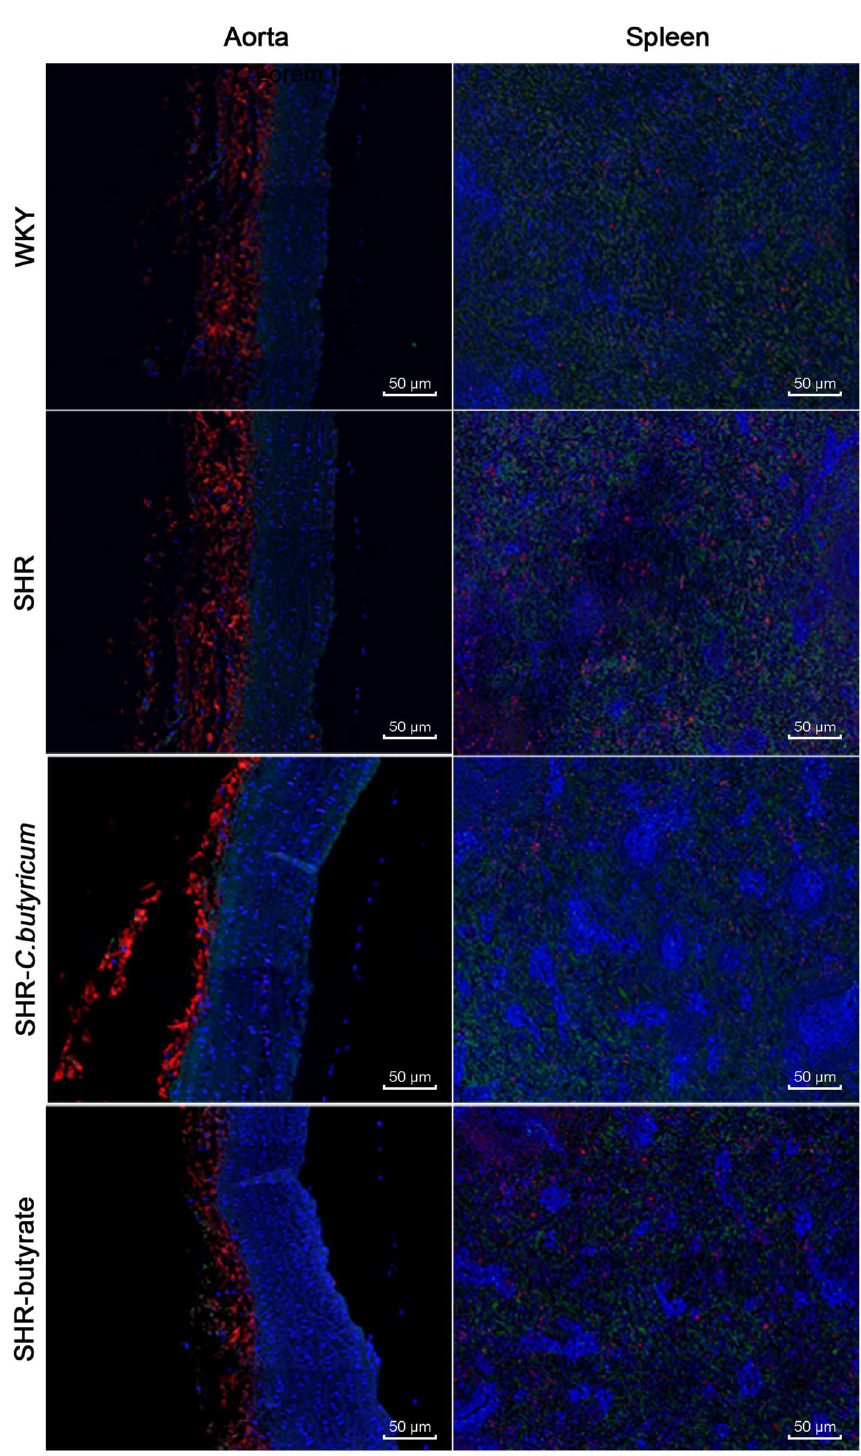
Figure 8. SHR increased Th17 and decreased Treg in the aorta and spleen, which could be prevented by C. butyricum or butyrate treatment. Th17 staining is shown in red, Treg staining is shown in green, and nuclear DAPI staining is shown in